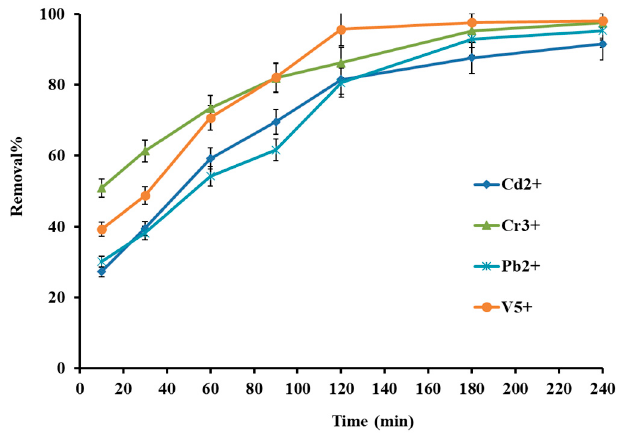
Figure 7. Effect of contact time on metal ion removal